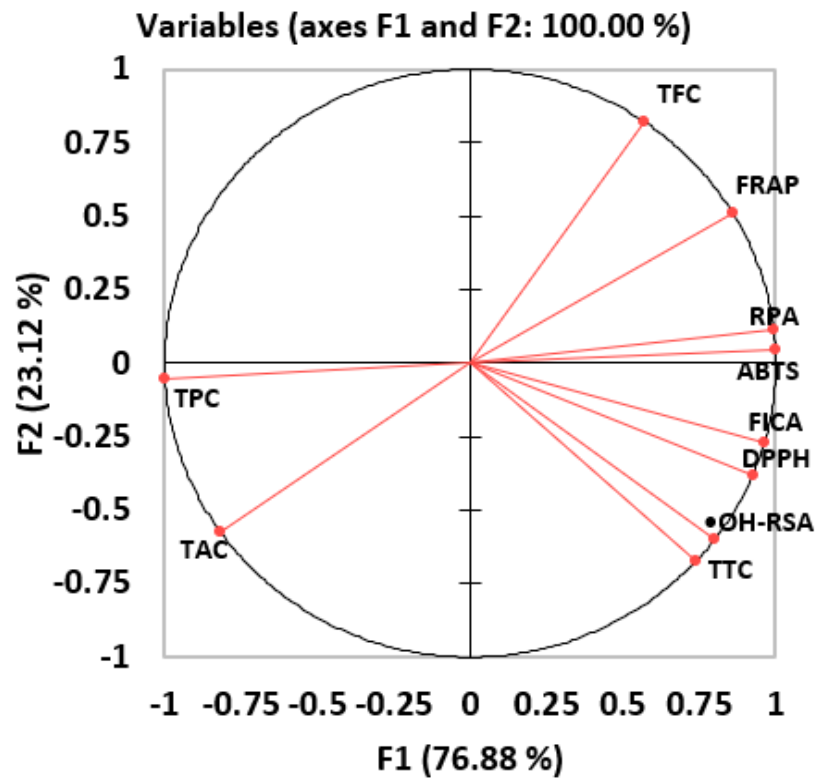
Figure 3. Correlations of ten antioxidant assays. Principal component analysis (PCA) of phenolic content (TPC, TFC and TCT) and antioxidant activities (FICA, • OH − RSA, RPA, DPPH, ABTS, FRAP and TAC) of twelve date samples.